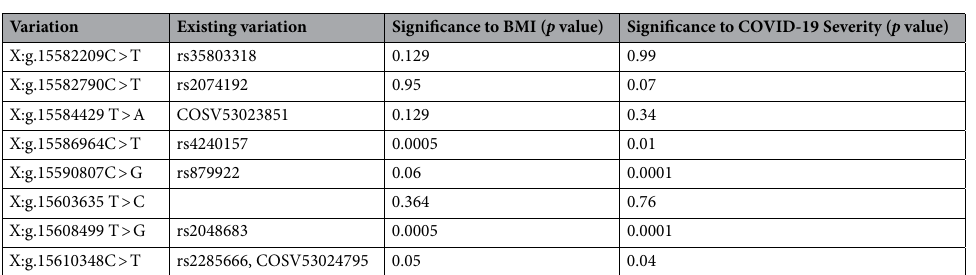
Table 2. A summary of the significance of ACE2 variants according to BMI and COVID-19 Severity in COVID-19 patients.